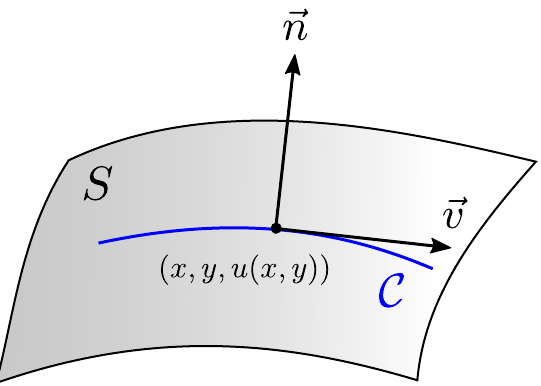
Figure 1 . The characteristic curve C lies in the solution plane S . At each point ( x, y, u ( x, y )) , the tangent vector of C is given by ~v = ( a ( x, y ) , b ( x, y ) , c ( x, y )) and the normal vector is given by ~n = ( ∂ x u ( x, y ) , ∂ y u ( x, y ) , − 1)